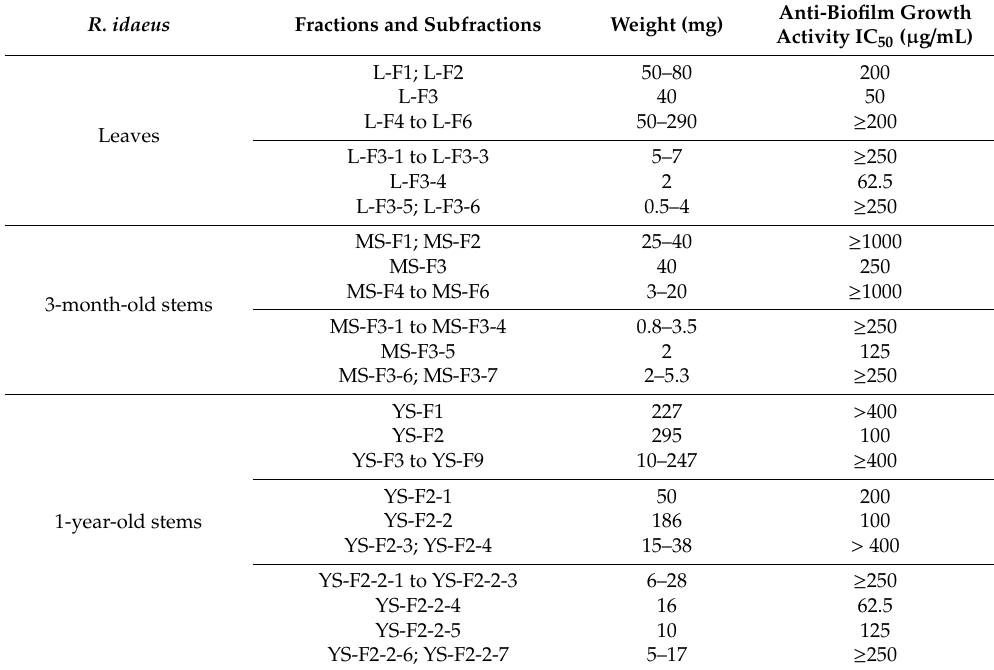
Table 2. Weight and anti-biofilm growth activity against C. albicans of all fractions obtained from hexane extracts of R. idaeus leaves, 3-month and 1-year-old stems. Biological results are expressed as 50% inhibitory concentration ( p < 0.05). All experiments were carried out in triplicate with at least three replicate